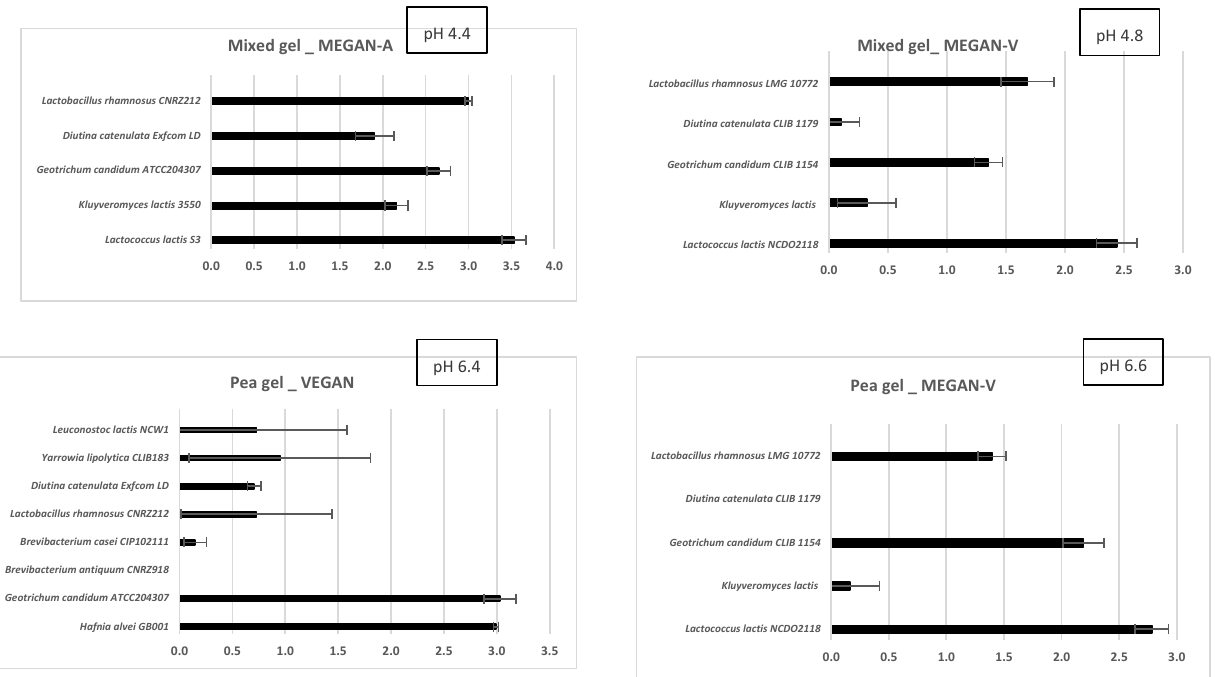
Figure 1. Growth (expressed as logN/N0, N: growth of strains at three days of fermentation; N0: initial cell density) of microbial species and pH values during the fermentation of pea gel and mixed gel (pea and milk) by three microbial communities (VEGAN, MEGAN-A, and MEGAN-V).